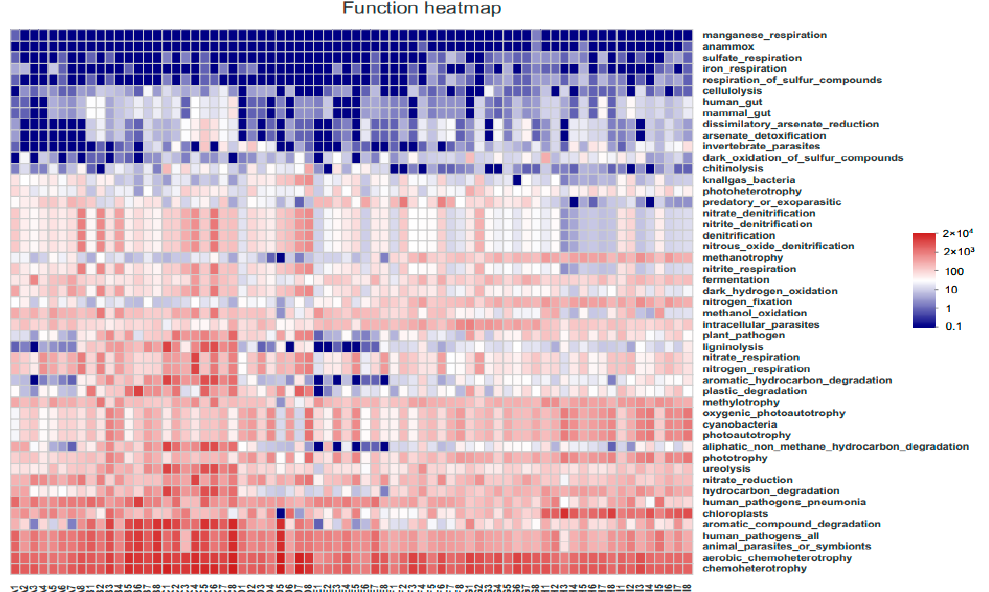
Figure 10. Heatmap of FAPROTAX function prediction. The X-axis is the sample name, and the Y-axis is the functional name. The abundance changes of different functions in the sample are shown by the color gradient of color blocks.